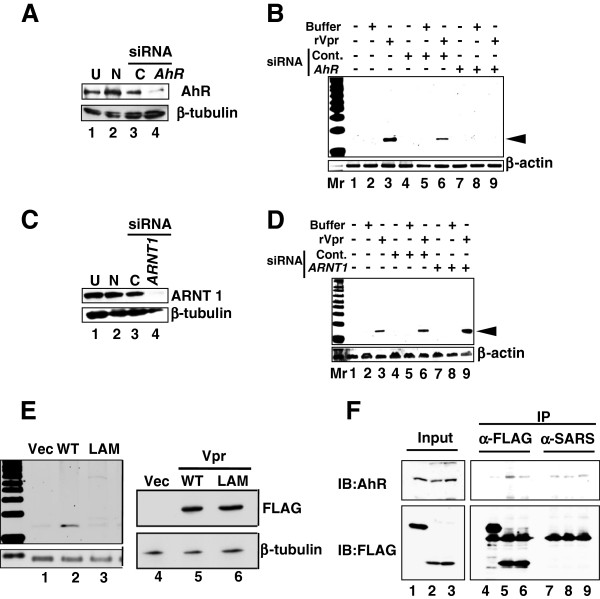
AhR is required for rVpr-induced L1-RTP. A. AhR siRNA down-regulated expression of endogenous protein. Lane 1, untreated (U); lane 2, mock transfection without siRNA (N); lane 3, control siRNA (C); lane 4, AhR siRNA. B. AhR siRNA attenuated rVpr-induced L1-RTP. C. ARNT1 siRNA down-regulated expression of endogenous ARNT1 protein. Lane 1, untreated (U); lane 2, mock transfection without siRNA (N); lane 3, control siRNA (C); lane 4, ARNT1 siRNA. D. ARNT1 is dispensable for L1-RTP induction by rVpr. E. No induction of L1-RTP by the LA mutant. Left panel. Result of L1-RTP after transfection of plasmid DNA encoding wild-type Vpr (WT) or the LA mutant. Lanes 1 and 4, vector control (Vec); lanes 2 and 5, WT Vpr; lanes 3 and 6, LA mutant (LAM). Right panel. Expression levels of WT Vpr and the LA mutant were comparable. F. Association with AhR was impaired in the LA mutant. HEK293T cells were transfected with constructs expressing FLAG-EGFP, FLAG-Vpr-Wt or FLAG-Vpr-LAM. Cell extracts were subjected to IP with α-FLAG followed by WB using α-AhR (upper panel) or α-FLAG (lower panel). Lanes 1, 4 and 7, vector control (FLAG-EGFP); lanes 2, 5 and 8, FLAG-Vpr-Wt; lanes 3, 6 and 9, FLAG-Vpr-LAM. α-SARS mAb was used for control-IP.